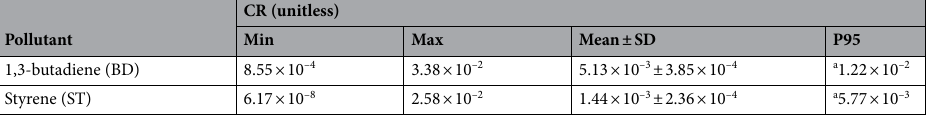
Table 3. Carcinogenic risk (CR) and probability distribution of BD and ST in the inhalation exposure to the employees in carpet industry. a The lifetime cancer risk value exceeds the acceptable level (10 −6 ); P95 – 95th percentile.